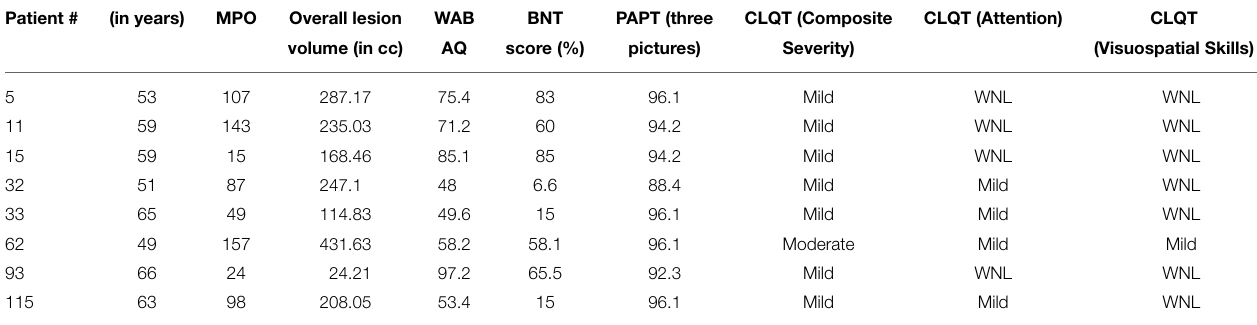
TABLE 1 | Demographic information for participants in the study that include age, months post onset (MPO), Western Aphasia Battery Aphasia Quotient (WAB AQ), Boston Naming Test (BNT), Pyramids And Palm Trees (PAPT, 3 pictures test), Cognitive Linguistic Quick Test (CLQT), and overall lesion volume in cc.